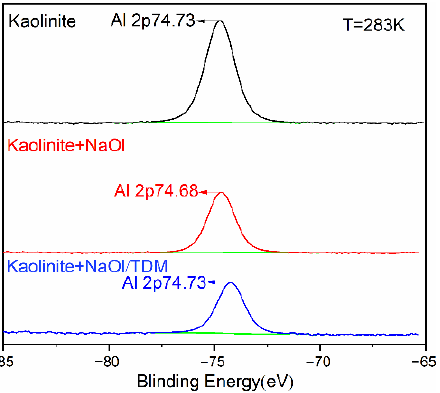
Figure 10. XPS spectra of the Al 2p layer of kaolinite with different collectors at 283 K.